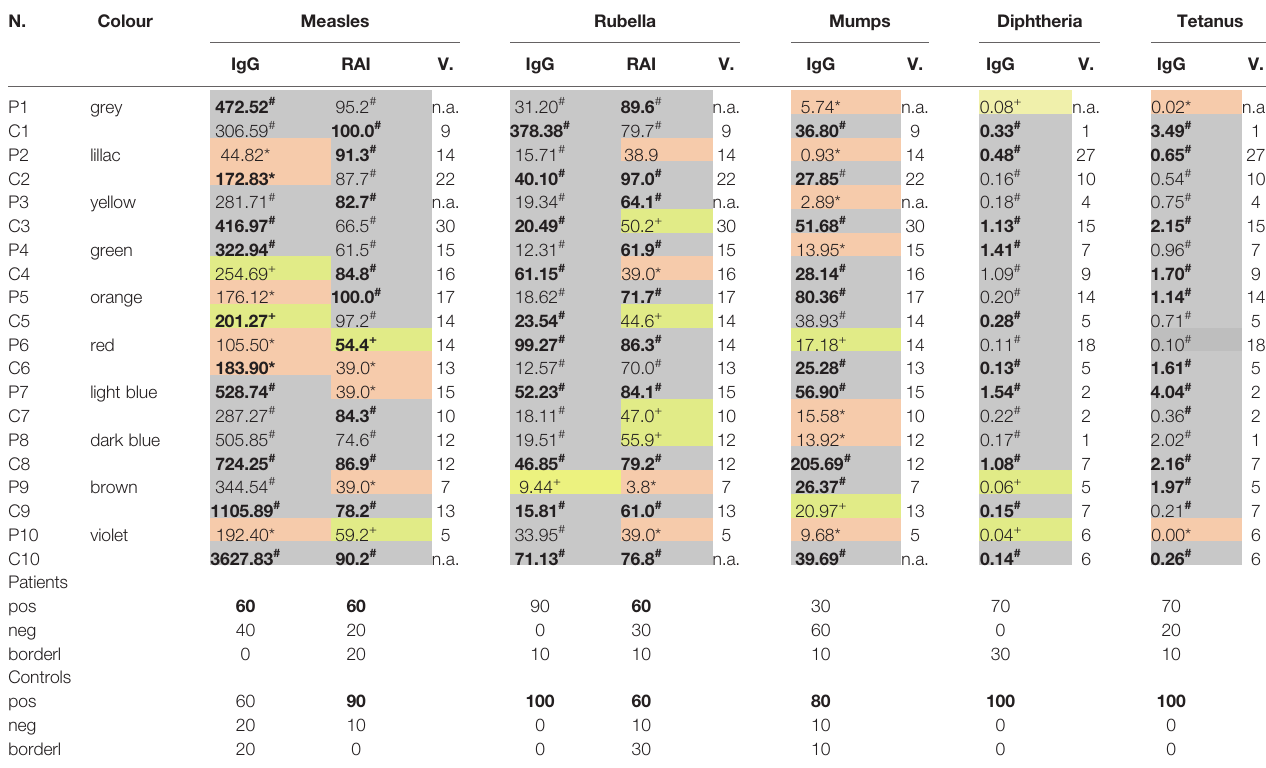
TABLE 2 | Detailed comparison of IgG speci fi c antibody concentrations, RAI and time since last vaccination in paired age- and sex-matched patients and controls.